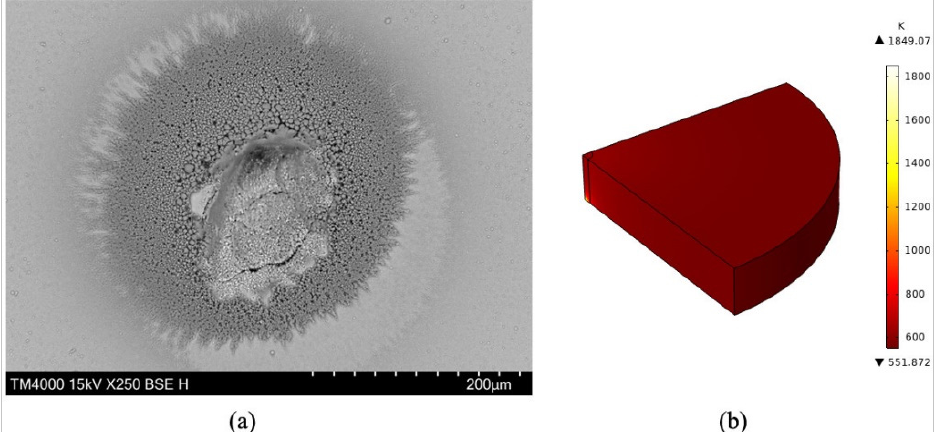
Figure 7. Schematic diagram of the variation of the Von Mis stress ( σ v ) at the center of the laser beam at the laser power densities of 1000, 5000, 9000, 13,000 and 17,000 W/cm 2 .